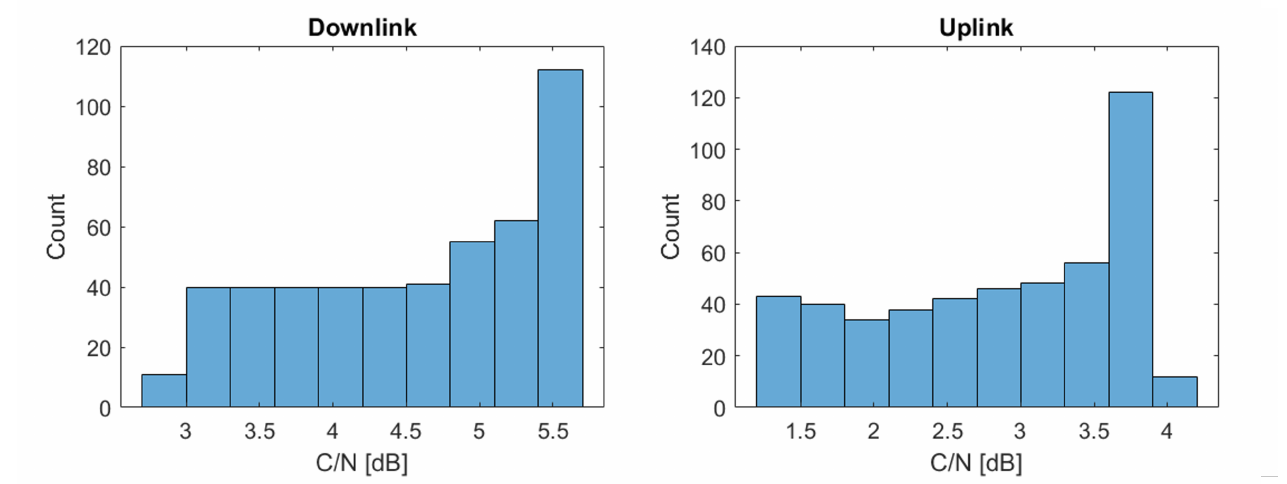
Figure 24. Carrier to Noise Ratio histogram in the maritime